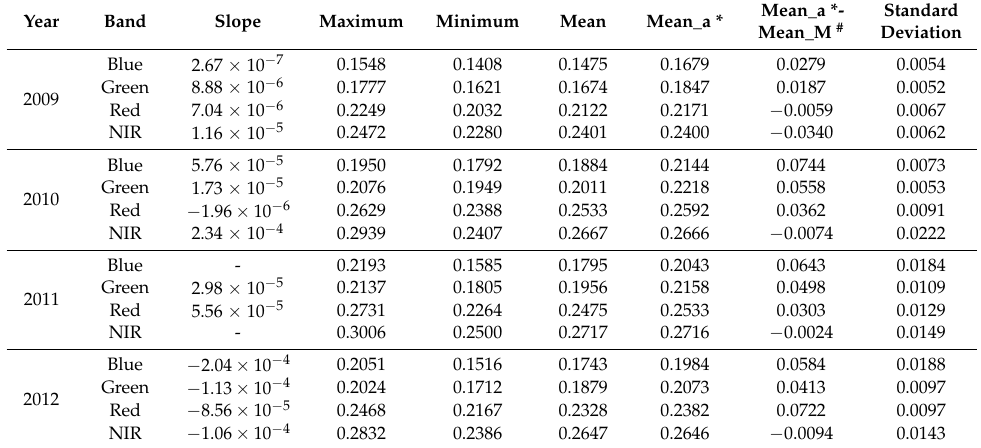
Table 8. The statistics from the time series of the TOA reflectance of HJ-1A/CCD1.